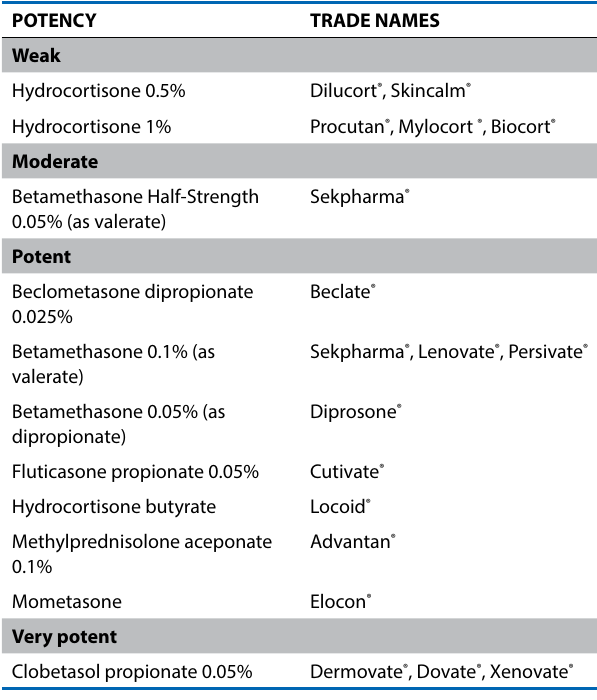
Table 2 . Different topical corticosteroids used in AD, including their potency and trade names 29